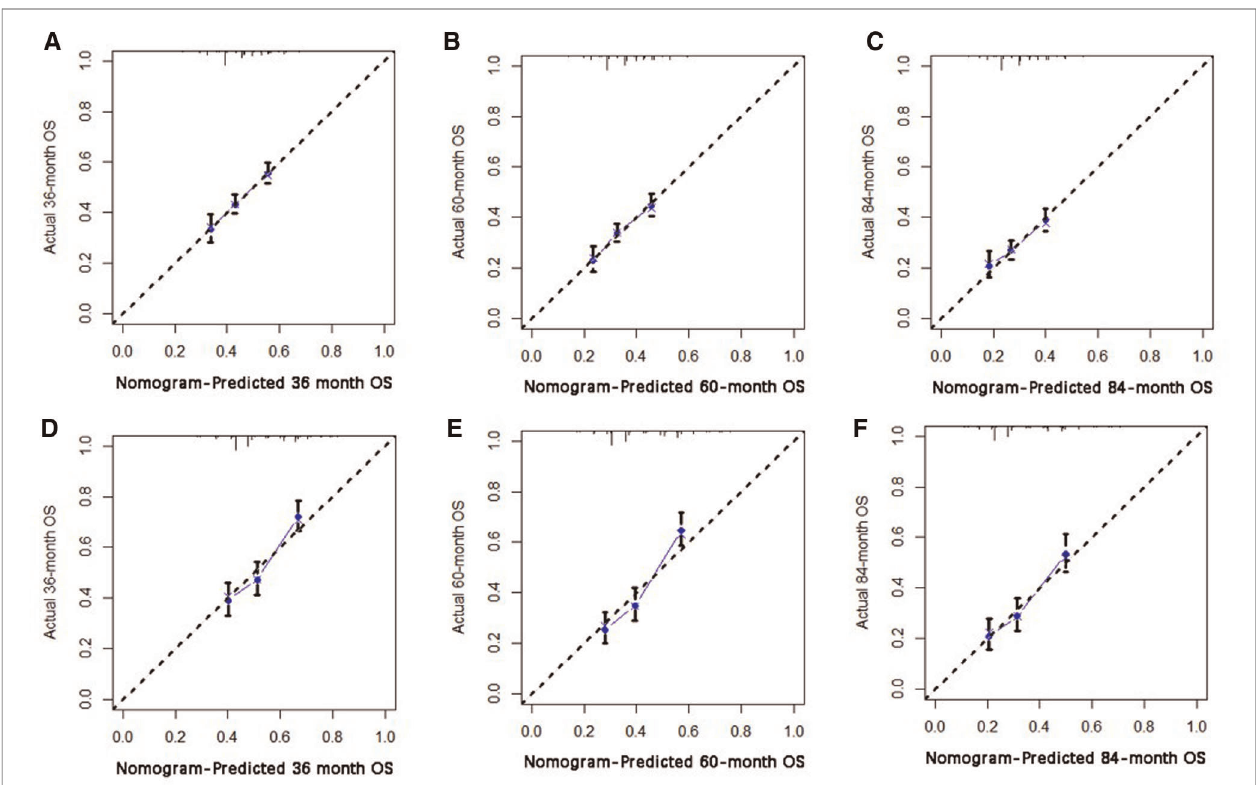
FIGURE 5 | The calibration curve for predicting patient survival at ( A ) 36 months, ( B ) 60 months, ( C ) and 84 months in the training cohort, and at ( D ) 36 months, ( E ) 60 months, ( F ), and 84 months in the validation cohort. The nomogram-predicted probability of the overall survival rate is plotted on the X-axis, and the actual overall survival rate is plotted on the